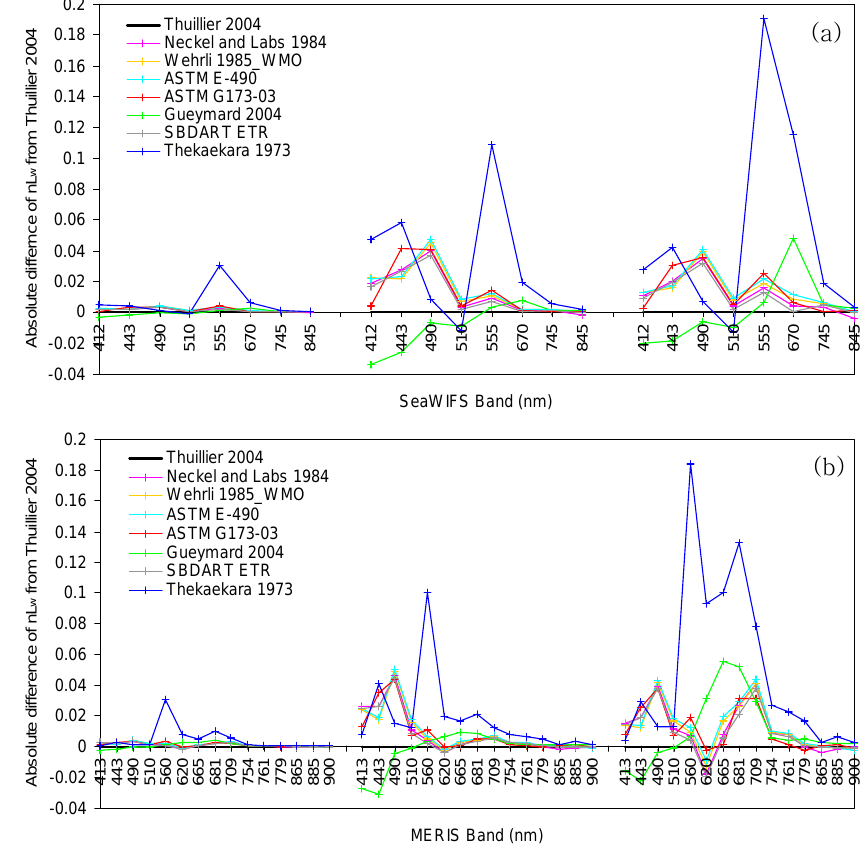
Fig. 7. The absolute nL w differences between the Thuillier 2004 and other spectra in SeaWiFS and MERIS channels.